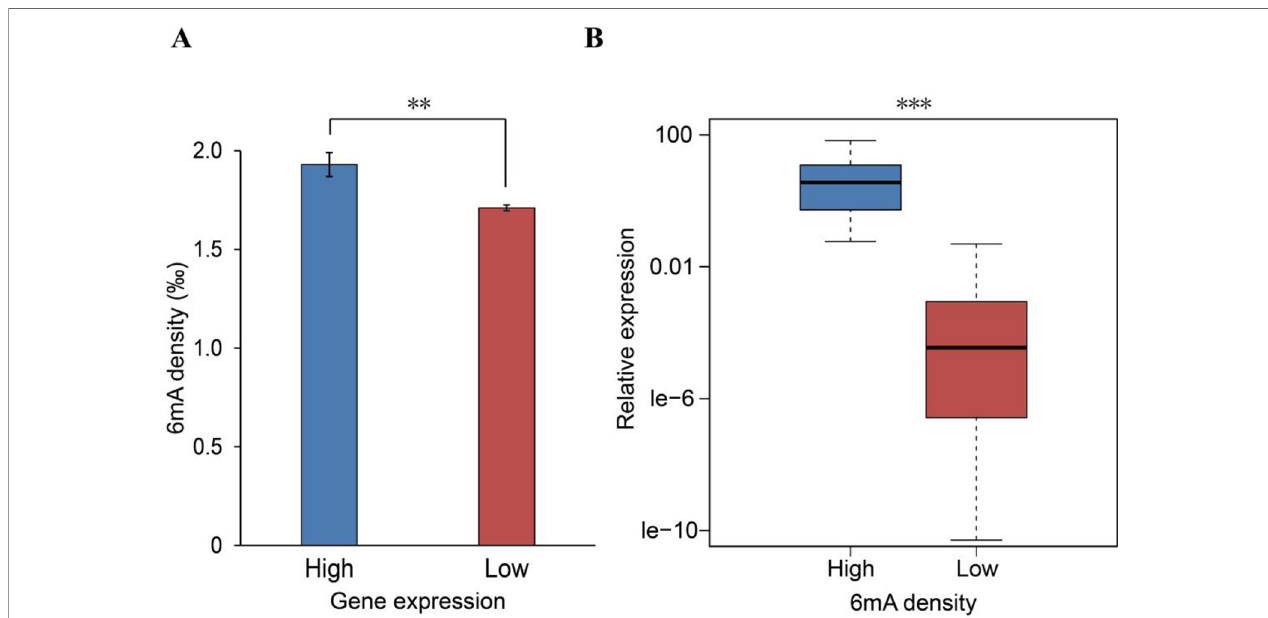
FIGURE 4 | Positive association between N 6 -methyladenine ( 6mA ) density and gene expression. (A) Computational analysis of the 6mA density in low-expression ( n = 10,873) and high-expression ( n = 1,852) genes (mean ± SEM, ** p < 0.01). (B) Experimental analysis of 60 randomly selected genes from among those with the highest (30) and lowest (30) 6mA methylation densities (*** p < 0.001). P values were calculated by Student ’ s t